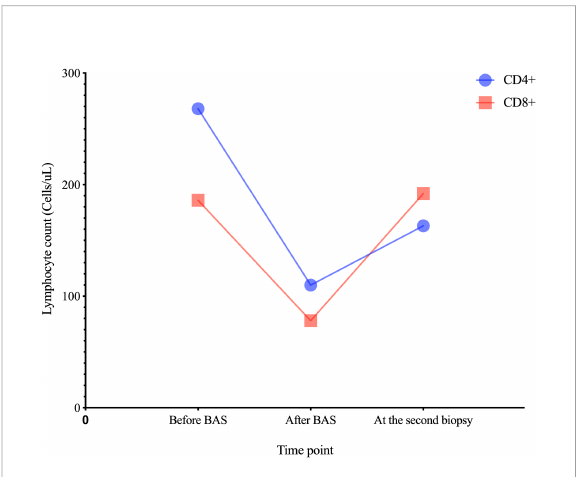
FIGURE 3 The CD4+ and CD8+ T cells levels at different time